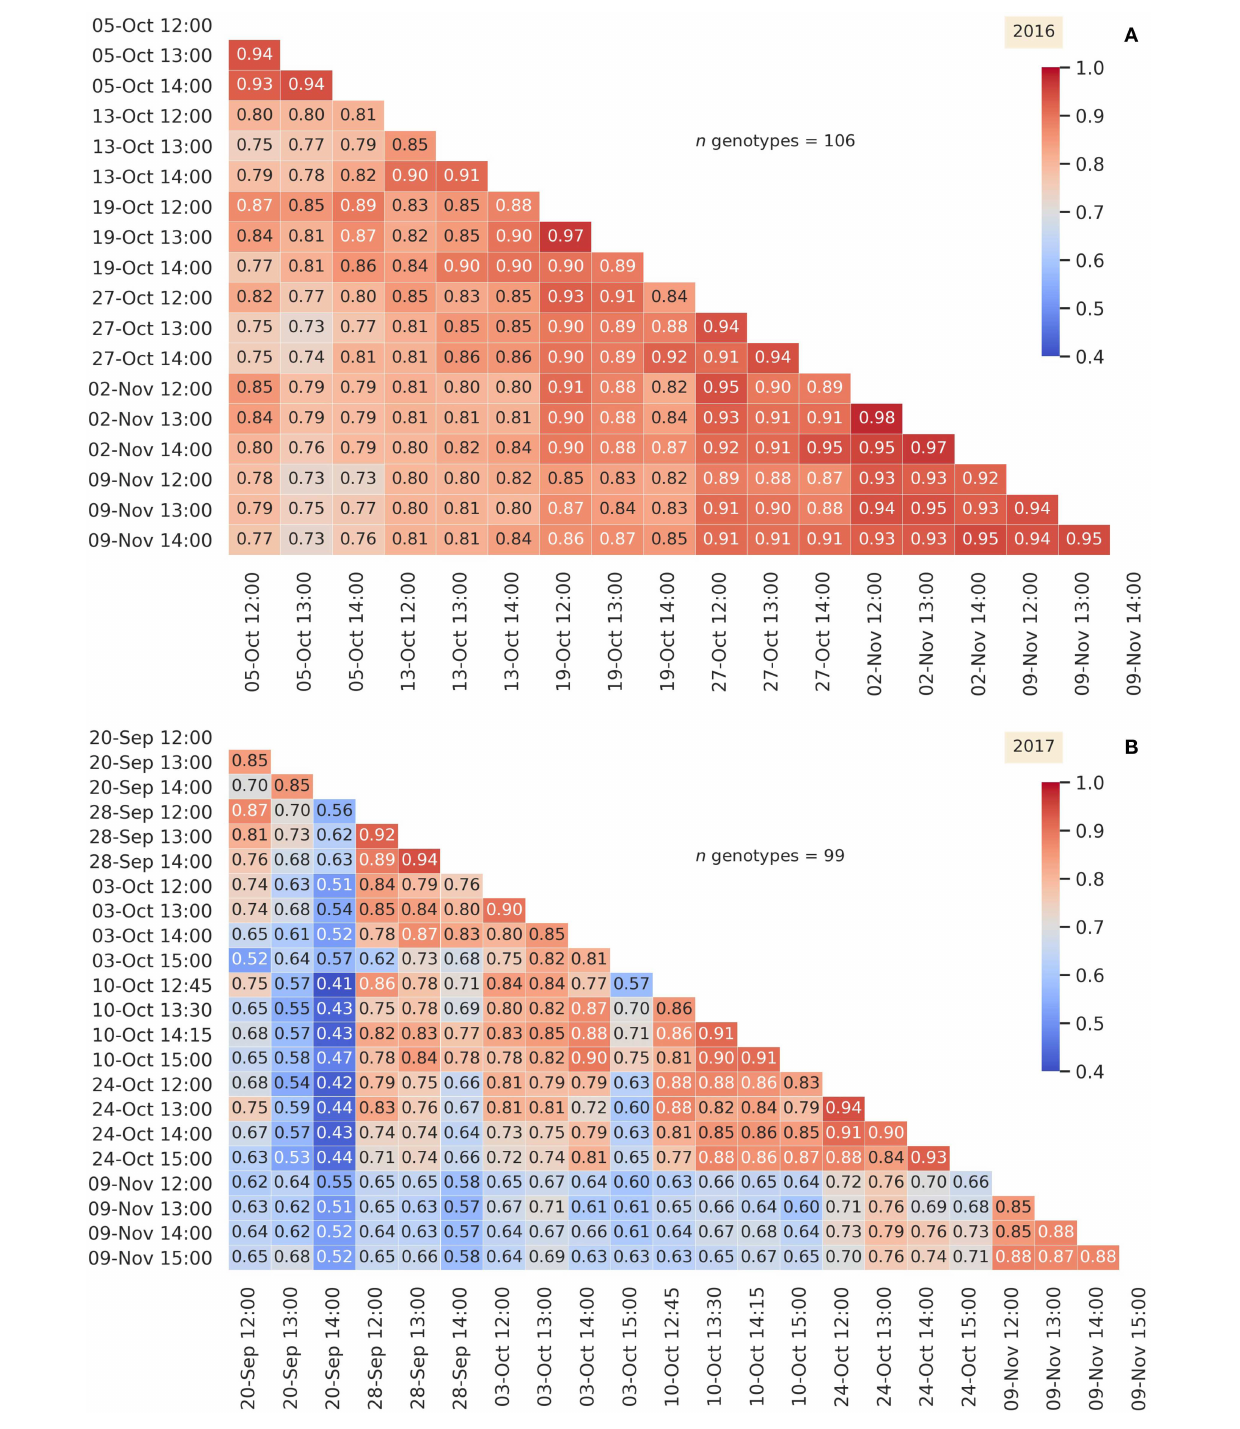
FIGURE 7 | Heatmaps of phenotypic correlations between the best linear unbiased predictors of genotype effects (BLUPs) for selected airborne canopy temperature events in 2016 (A) and 2017 (B) . For 2016, on each day after (and including) 12:00. For 2017, for events on days after and including 20-Sept and after 12:00.